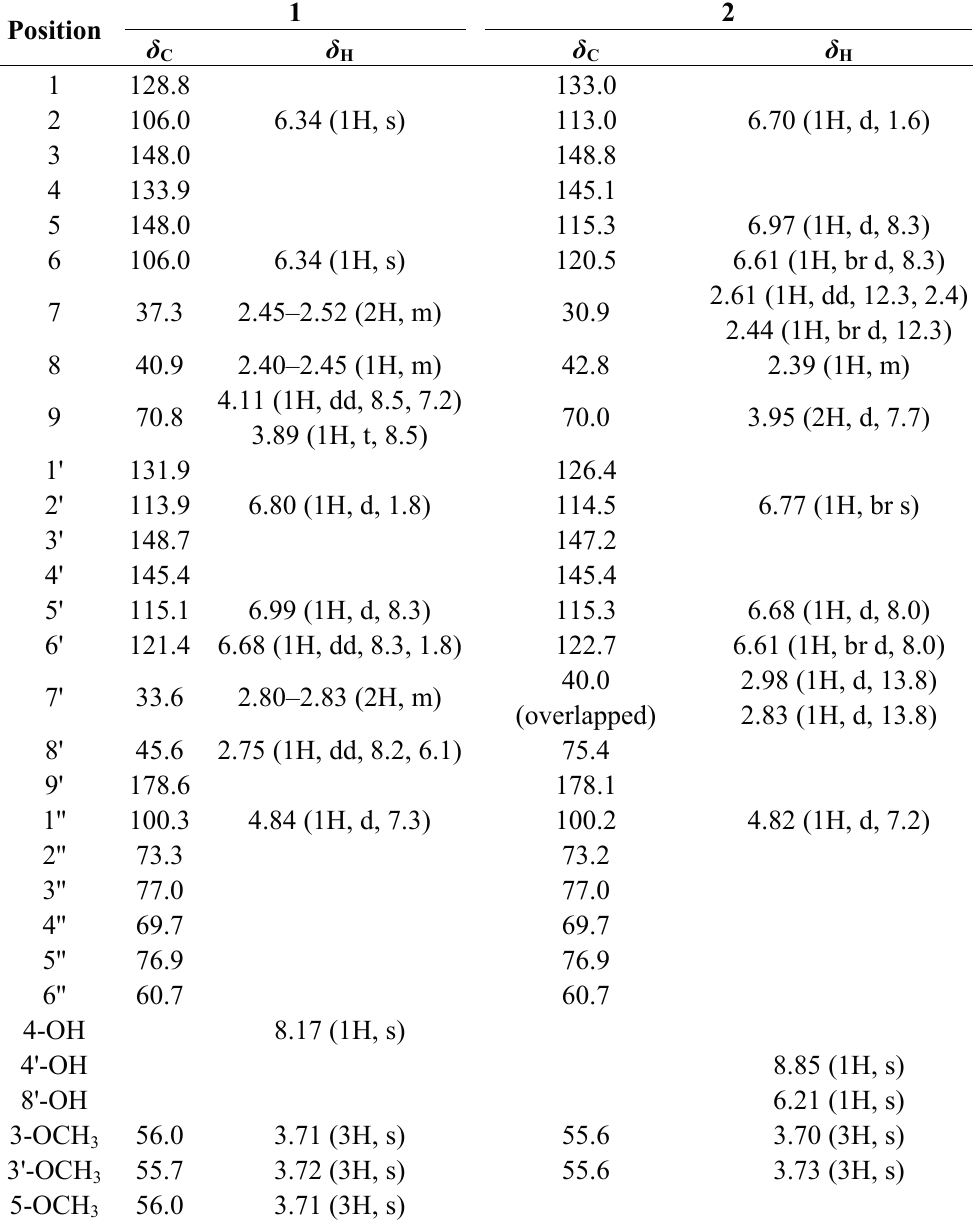
Table 1. 1 H-NMR (400 MHz) and 13 C-NMR (100 MHz) spectral data of compounds 1 and , δ in ppm, J in Hz). 2 (in DMSO- d 6